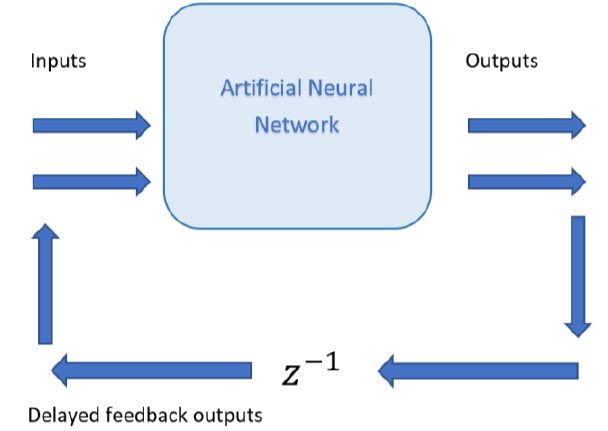
Figure 2. Recurrent neural network.